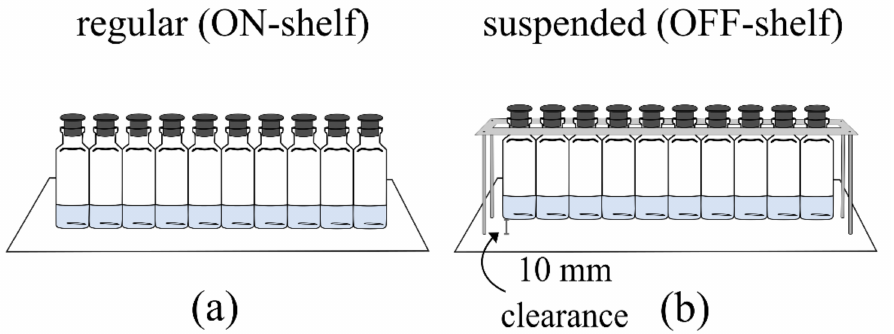
Figure 1. Experimental setup representations (not to scale): ( a ) the ON-shelf and ( b ) OFF-shelf vial configurations